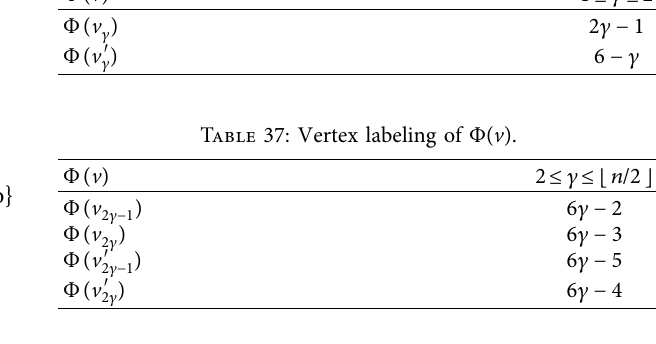
Table 38: Edge labeling of Φ ∗ ( e )